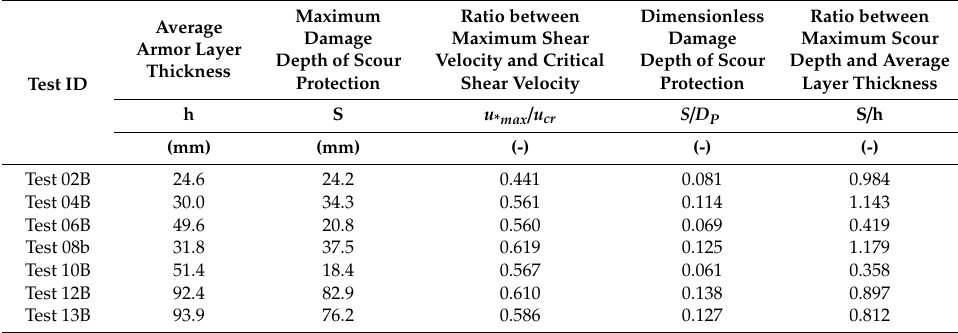
Table 7. Maximum damage depth in present large scale test.